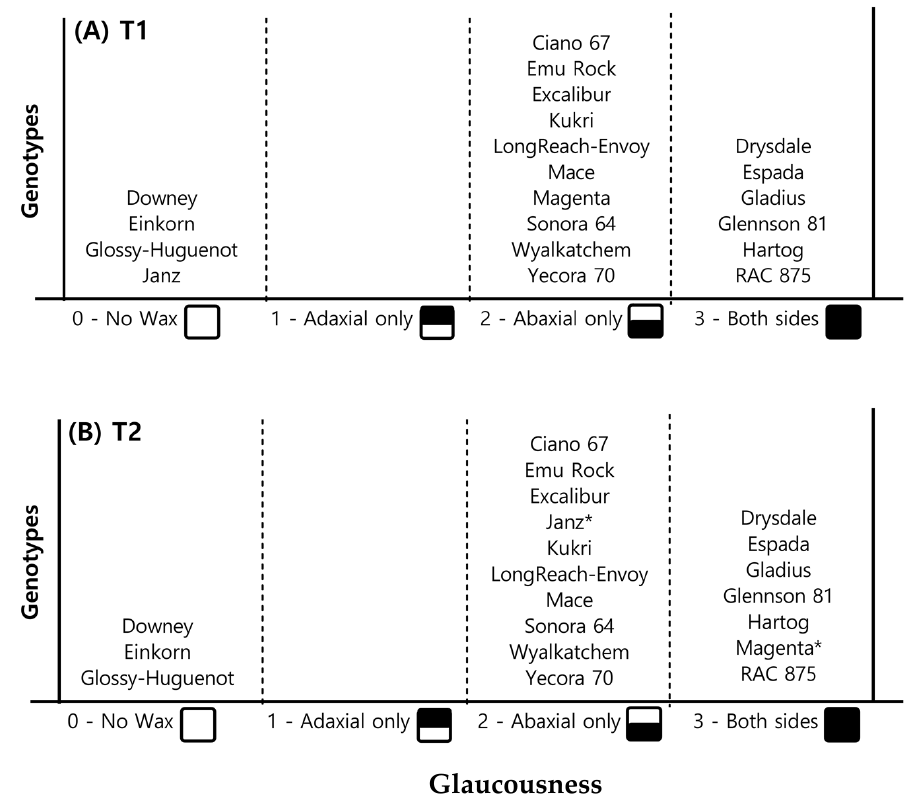
Figure 2. Categorization of wheat genotypes (Batch 01 and Batch 02) based on glaucousness (blueish/white waxy deposition) of leaves under ( A ) ambient (T1), and ( B ) high (T2) temperature regimes. T2 enhanced glaucousness, especially in genotypes indicated by *.